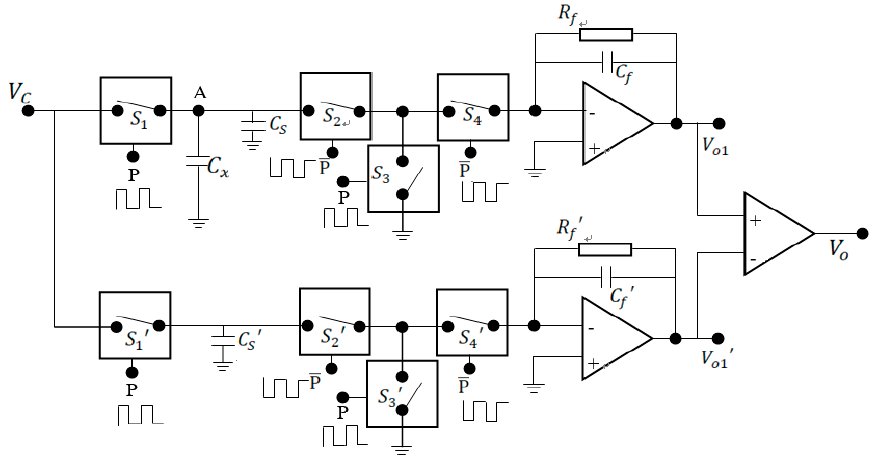
Figure 13. A capacitance measurement circuit with differential output for water leakage monitoring and detection.